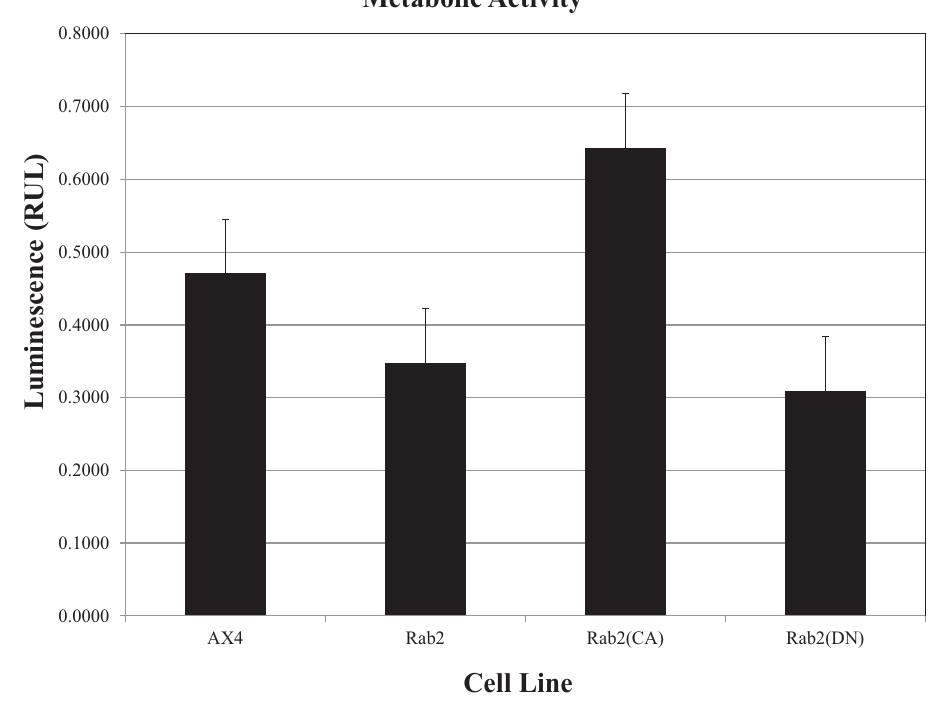
Figure 7. ATP levels are affected in DdRab2 over-expressing, and mutant cell lines. To measure the ATP levels, luminescence was recorded 10 min after CellTiter-Glo ® reagent was added to cells in a 96-well plate. Data represent the average of three independent experiments with a p -value > 0.05. There was a decrease (not significant) in the luminescent signal from the Rab2 over-expressing, and Rab2(DN) cells, and an increase in Rab2(CA) cells as compared to the AX4 cell